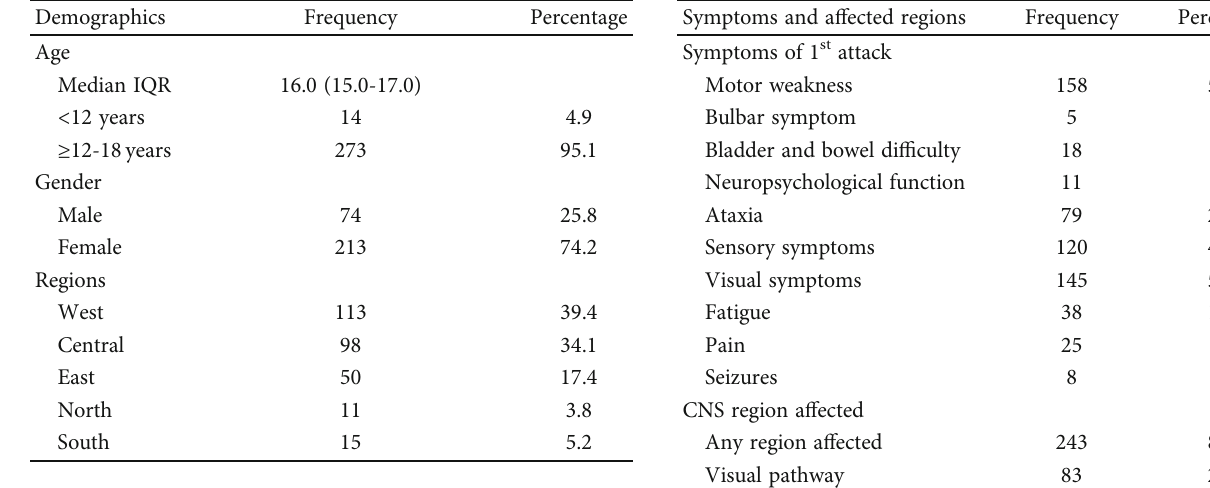
Table 3: Baseline characteristics of individuals with pediatric onset of MS ( n = 287 ).